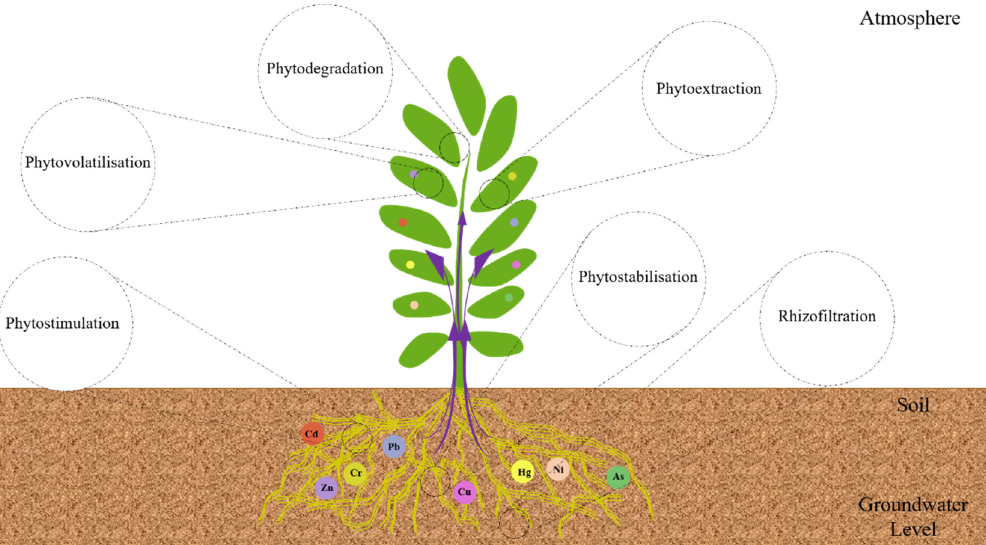
Figure 5. The mechanisms by which plants absorb heavy metals via phytoremediation technology.